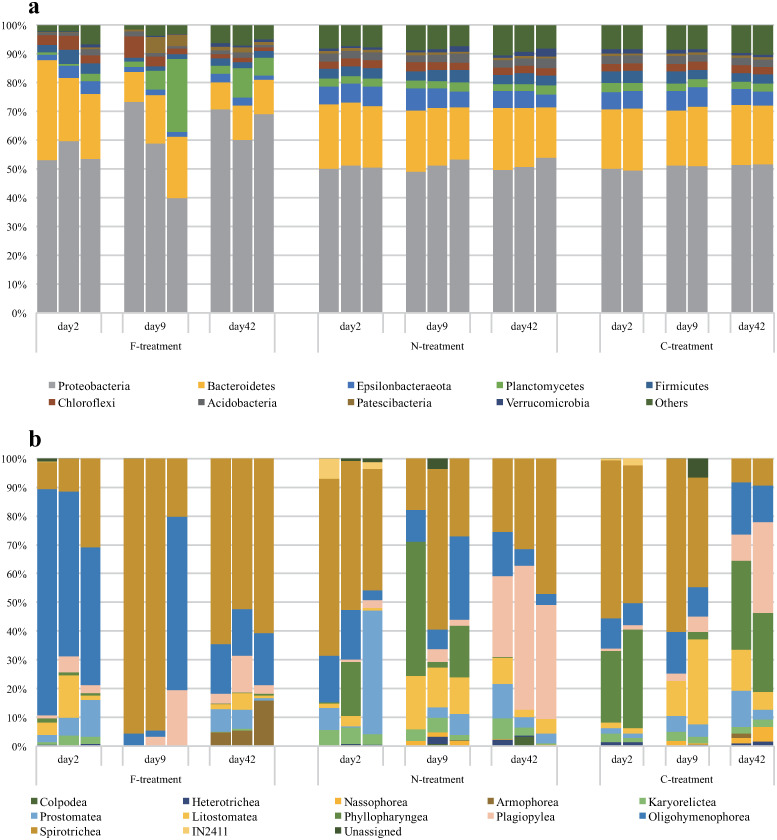
Temporal changes in the microbial assemblages in F-, N- and C-treatments.The relative abundances of (a) different Bacteria phyla based on 16S rRNA sequencing and (b) different Ciliophora classes based on 18S rRNA sequencing.